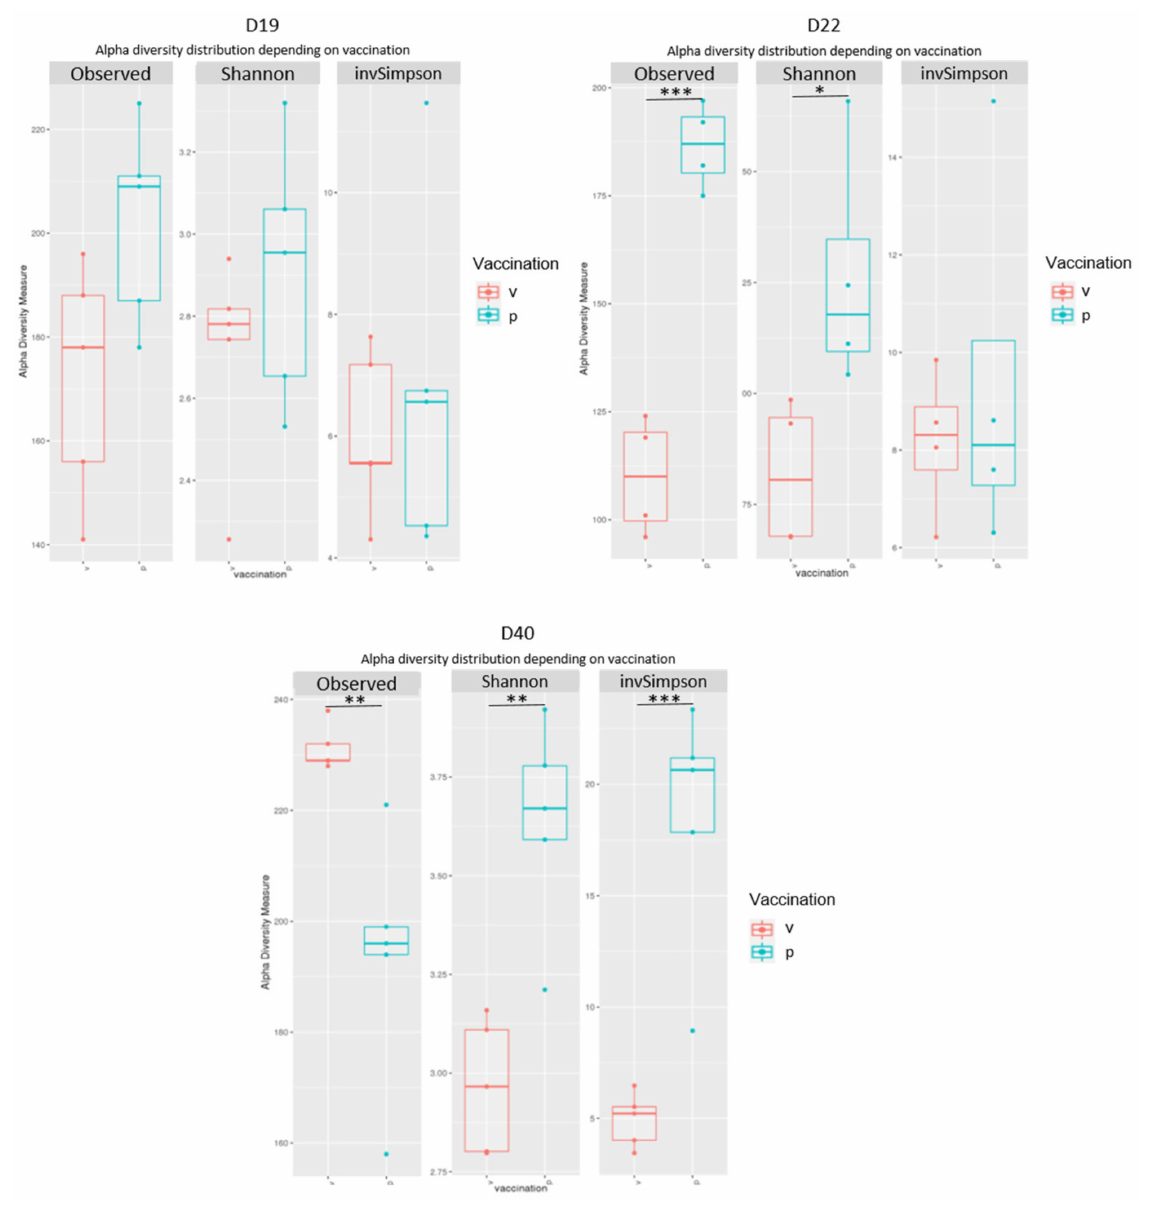
Figure 5. Richness and alpha diversity indices for chicken’s caecal microbiota on D19, D22 and D40. Significant differences between the vaccinated (v) group in red and placebo (p) group in blue are indicated by asterisks (* p < 0.05, ** p < 0.01, *** p <